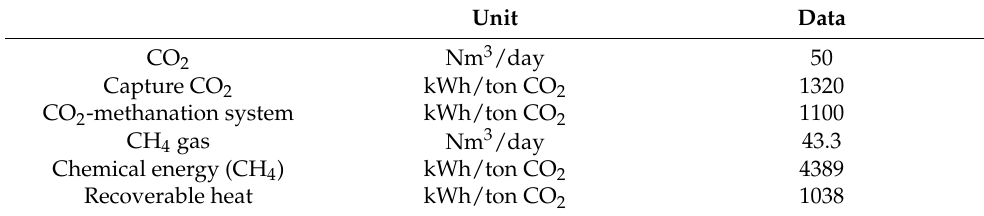
Table 2. CO 2 -methanation energy